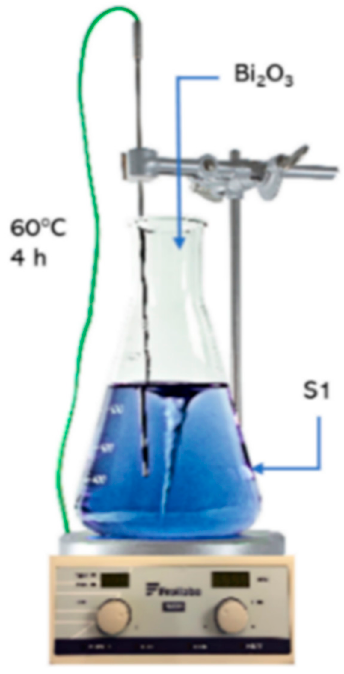
Figure 1. Procedure for preparation of S2, S3, S4 electrolytes.